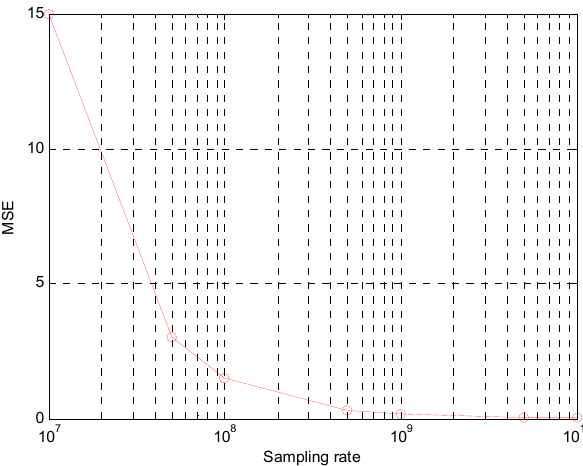
Figure 7. MSE of distances between MS and BSs for the second case.